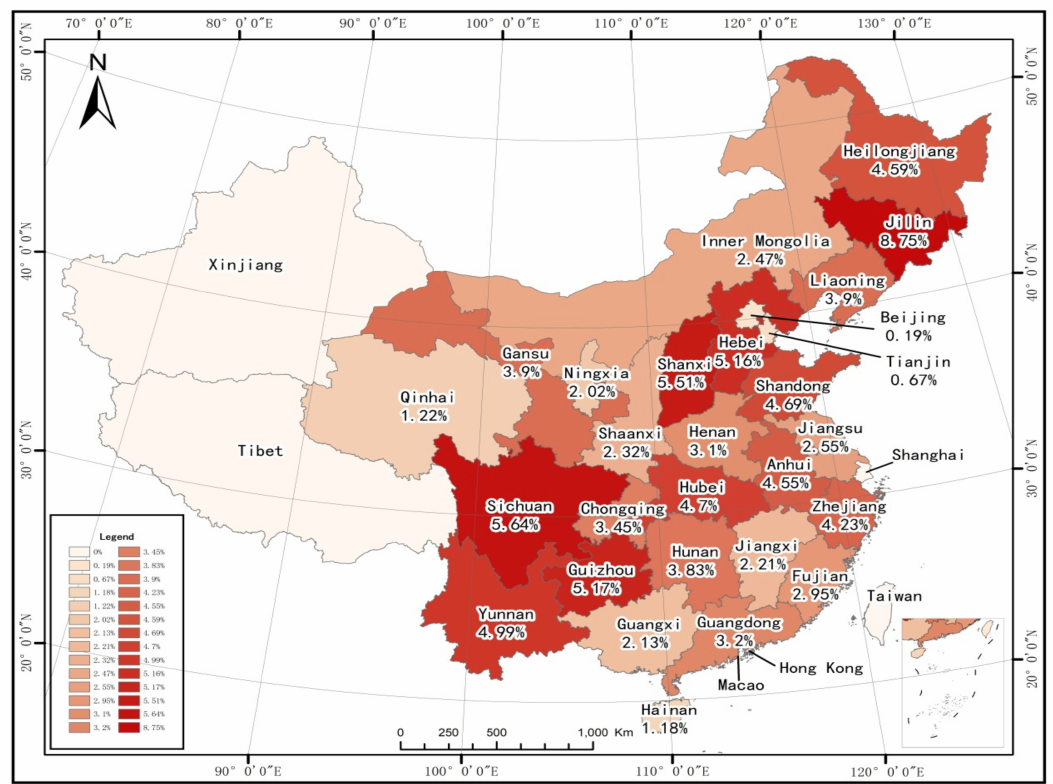
Figure 3. Sample